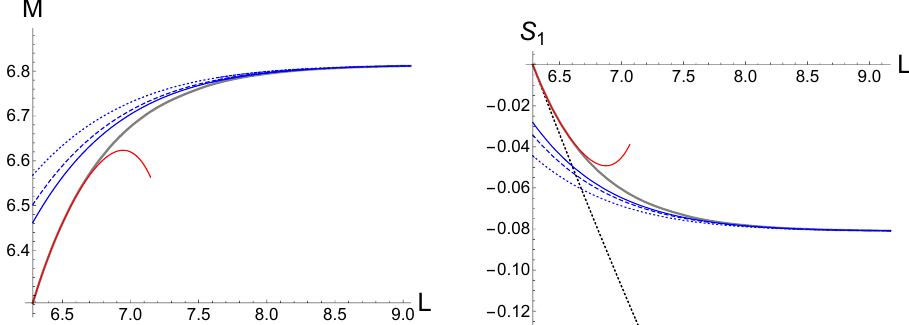
Figure 4 . The mass and the mass-normalized, scale-invariant entropy of the nonuniform black string for given period L . The gray and red curves correspond respectively to the numerical result and perturbative expansion in the small non-uniformity up to 8 -th order. The blue dotted, dashed and solid curves are the blob approximation up to LO, NLO and NNLO, respectively. The black dotted curve in the right panel is the scale-invariant entropy of the uniform string given by S 1 = log(2 π/L )